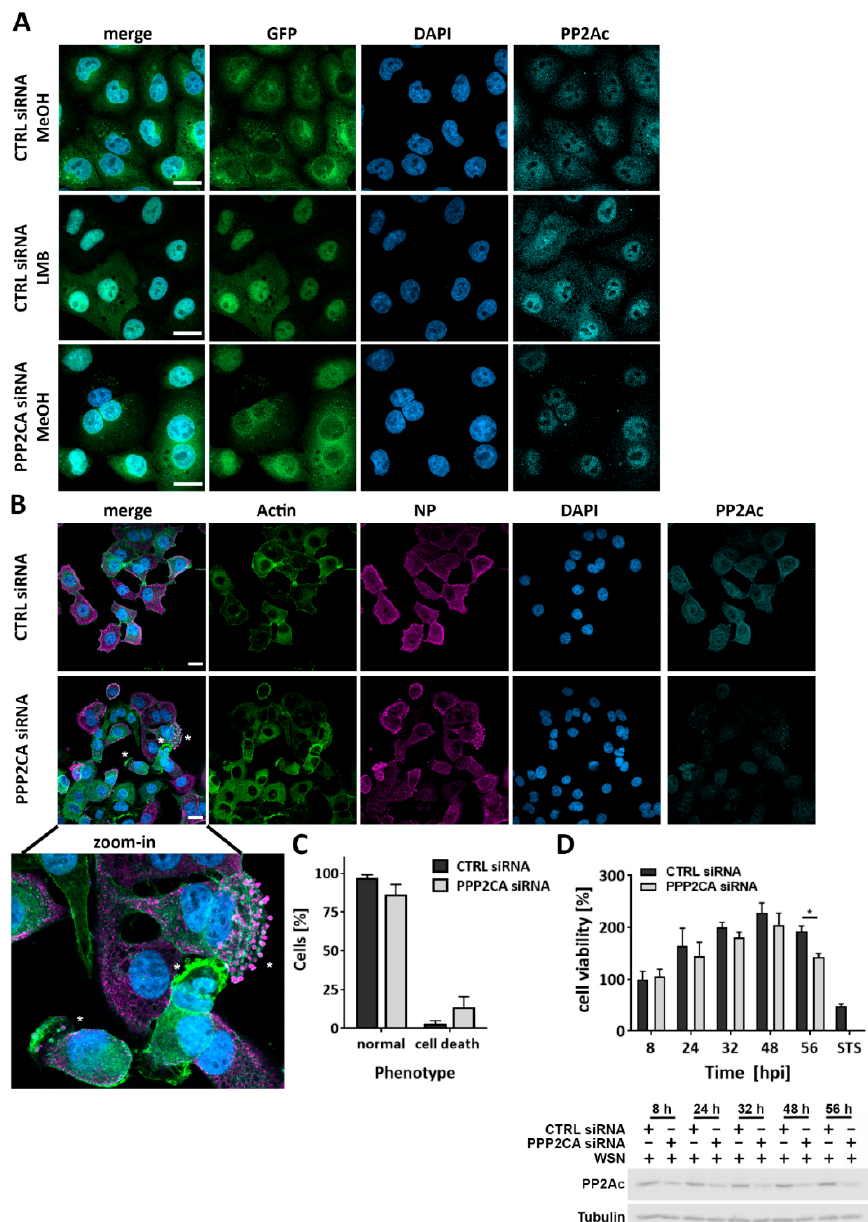
Figure 4. PP2A orchestrates cell survival mechanisms in IAV-infected cells. ( A ) A549 cells stably expressing a GFP biosensor were treated with leptomycin B (LMB) or methanol (MeOH) as solvent control, 48 h after siRNA-mediated KD of PP2Ac. Cells were fixed in 3.7% formaldehyde and nuclei were stained with 4 ′ ,6-diamidino-2-phenylindole (DAPI). ( B , C ) A549 cells were infected with WSN (MOI = 5) 48 h after siRNA-mediated KD of PP2Ac. Cells were fixed 8 hpi in 3.7% formaldehyde and stained with specific antibodies against the viral nucleoprotein (NP), actin and PP2Ac. Nuclei were stained with DAPI. All immunofluorescence pictures were analyzed with Fiji. Asterisks indicate membrane blebbing. Scale bar corresponds to 20 µm. ( C ) Cells with an obvious cell death phenotype were counted manually and expressed as percent of the total amount of counted cells. Data are represented as mean + SD of three independent experiments with at least 200 analyzed cells each. ( D ) A549 cells were infected with WSN (MOI = 0.01) 24 h after siRNA-mediated KD of PP2Ac. Cell viability was analyzed using an MTT-based assay. Staurosporin (STS, 1 µM) was used as a positive control. KD efficiency was analyzed using Western blotting. Data are depicted as mean + SD of one representative out of four independent experiments. ( C , D ) Statistical analysis was performed by using a two-way ANOVA with * p < 0.05.